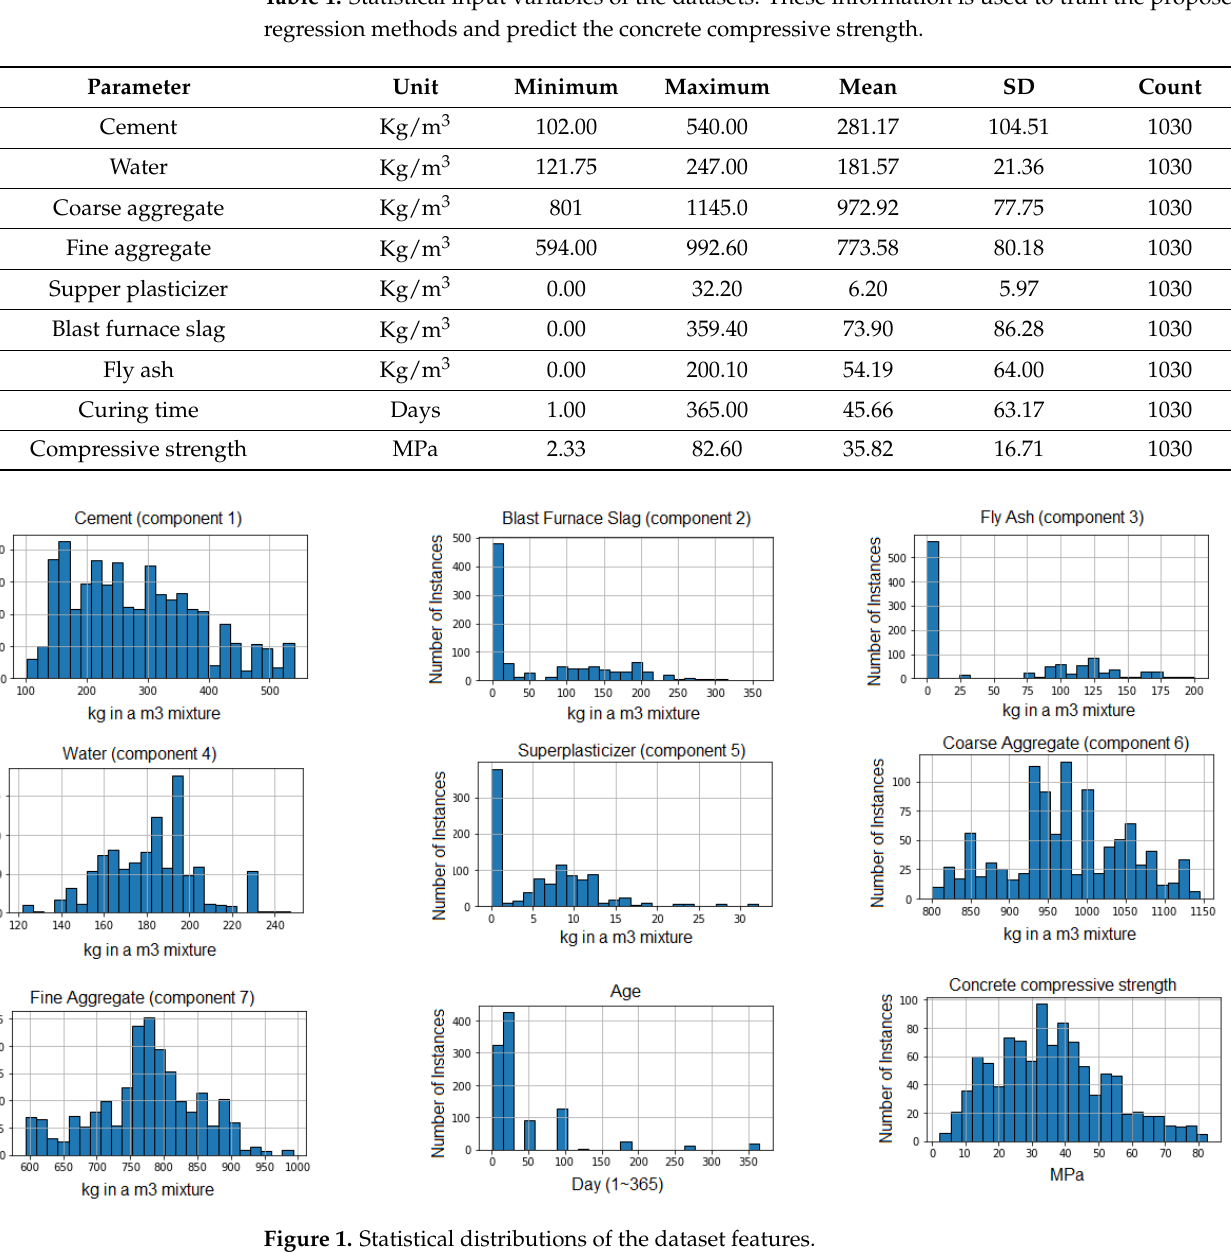
Figure 1. Statistical distributions of the dataset features.